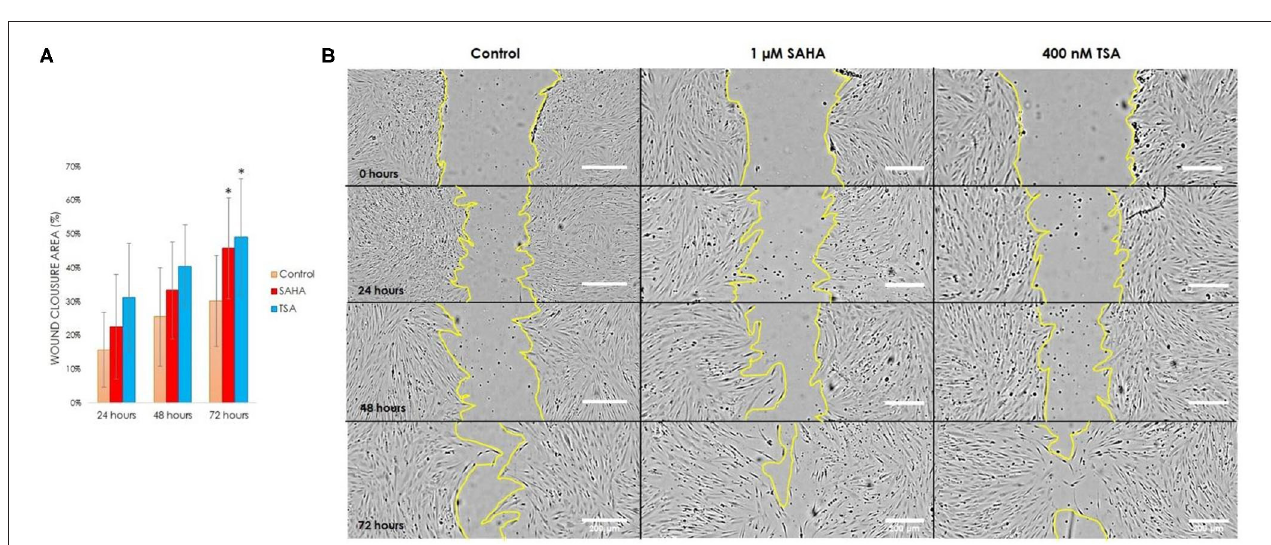
FIGURE 6 | Scratch wound healing assay evaluating cell migration during 72h in serum-free medium with/without TSA or SAHA. (A) Quantitative analysis of the wound closure area expressed as the percentage, (B) hDPCs migration at 0, 24, 48, and 72h of treatment; scale bar is 200 µ m (one-way ANOVA, Tukey’s HSD post hoc test, Asterisks indicate a significant difference compared with control at p < 0.05, n = 3).